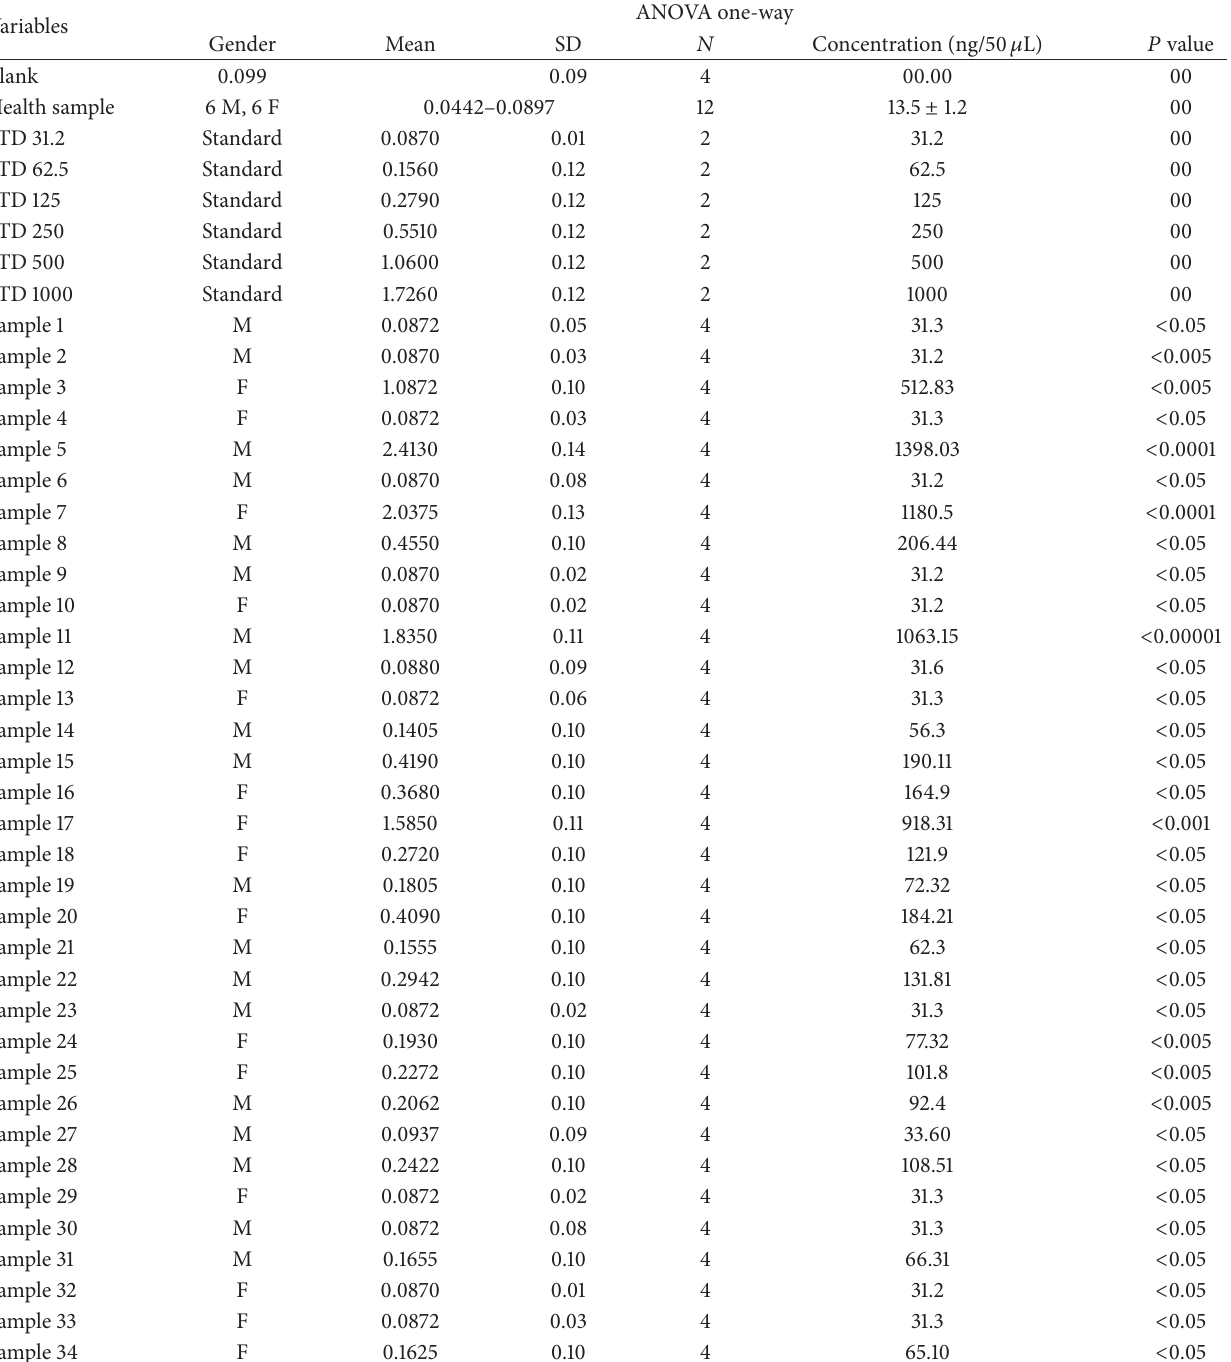
Table 2: Human 𝛼 -defensin concentration in HCV patients